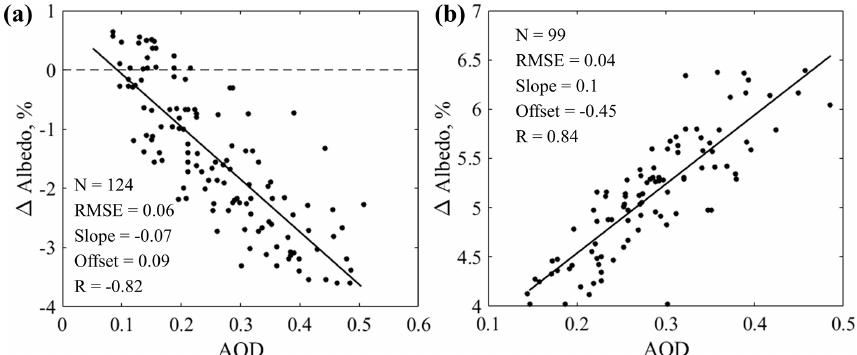
Figure 3. Sample scatterplots between MODIS AOD and CERES (cid:49)α . The solid lines represent the best-fits for (a) absorbing aerosols above the Sahara and (b) scattering aerosols above the Arabian Sea. τ c (AOD at which (cid:49)α is zero) is the x -intercept of the best-fit line.